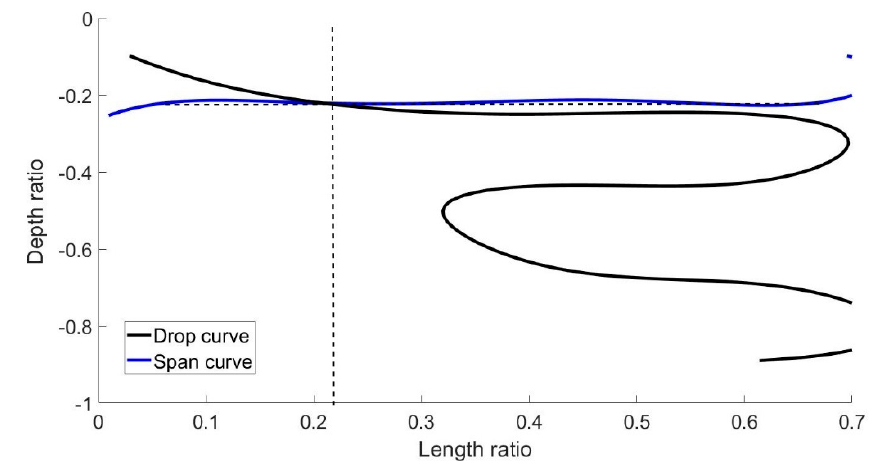
Figure 12. Intersection curves for drop = 3% and span = 1.1.